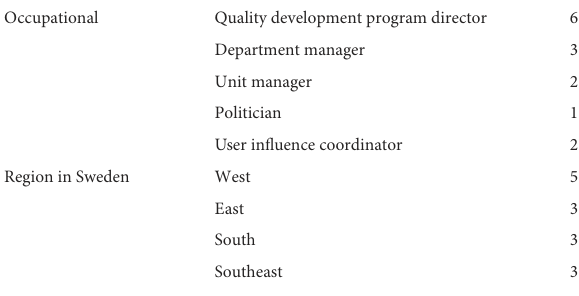
TABLE 1 Representatives of the mental health service system–workshop I and III ( N = 14).